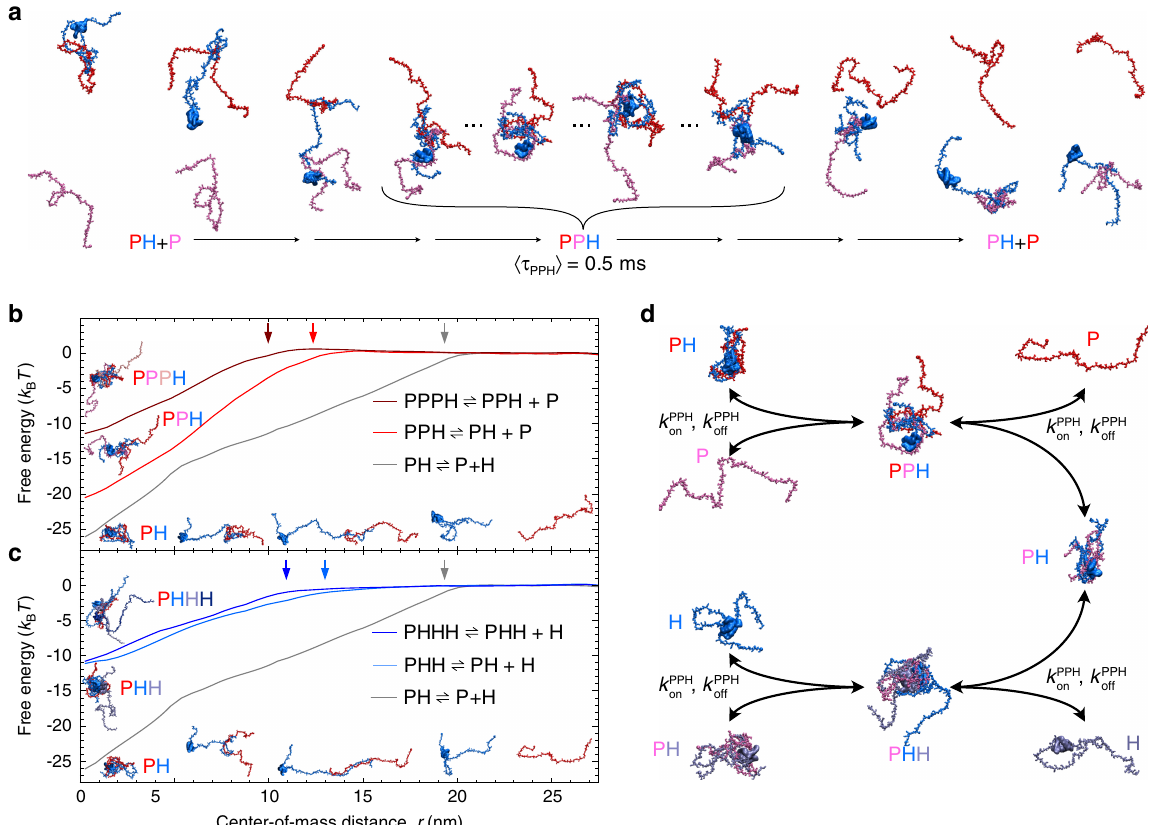
Fig. 5 Polyelectrolyte interaction mechanisms from molecular simulations. a Snapshots from coarse-grained molecular dynamics simulations (see Supplementary Movie 1) of a competitive substitution event via formation of a transient ternary complex PPH (average PPH lifetime, 〈 τ PPH 〉 ≈ 0.5 ms). A ProT α molecule (P, pink) associates with a preformed ProT α -H1 complex (PH), shares contacts with H1 (H, blue), and eventually replaces the ProT α molecule previously bound (P, red). The alternative scenario of association and dissociation of the same molecule of ProT α is shown in Supplementary Movie 2. b , c Potentials of mean force for the formation of the PH dimer, PPH and PHH trimers, and PPPH and PHHH tetramers (see legend) from umbrella sampling simulations, with snapshots of the oligomers (left) and of the formation of PH from P and H at different distances of their centers of mass, r (bottom). Approximate capture radii for the different complexes are indicated with colored arrows. d Kinetic scheme of dimer and trimer formation, including competitive substitution (color scheme as in a